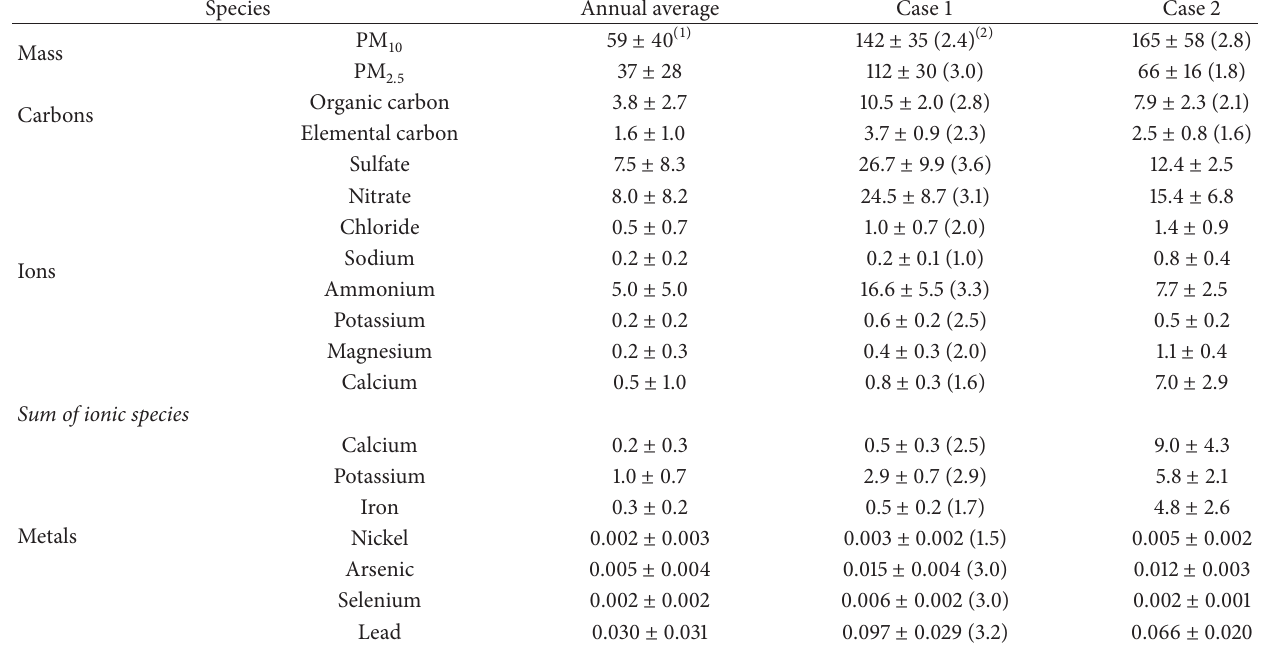
Table 2: Chemical composition of Case 1 and Case 2 compared to annual